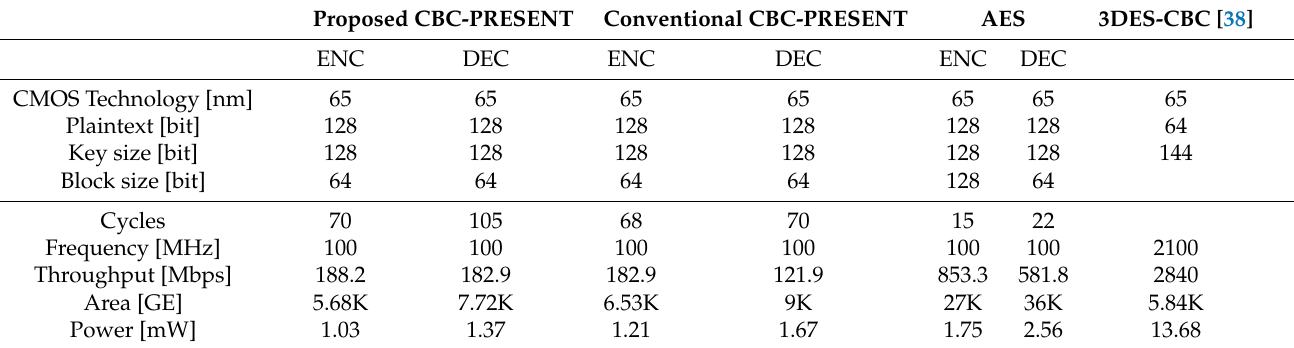
Table 1. Performance and security comparison of CBC-PRESENT.